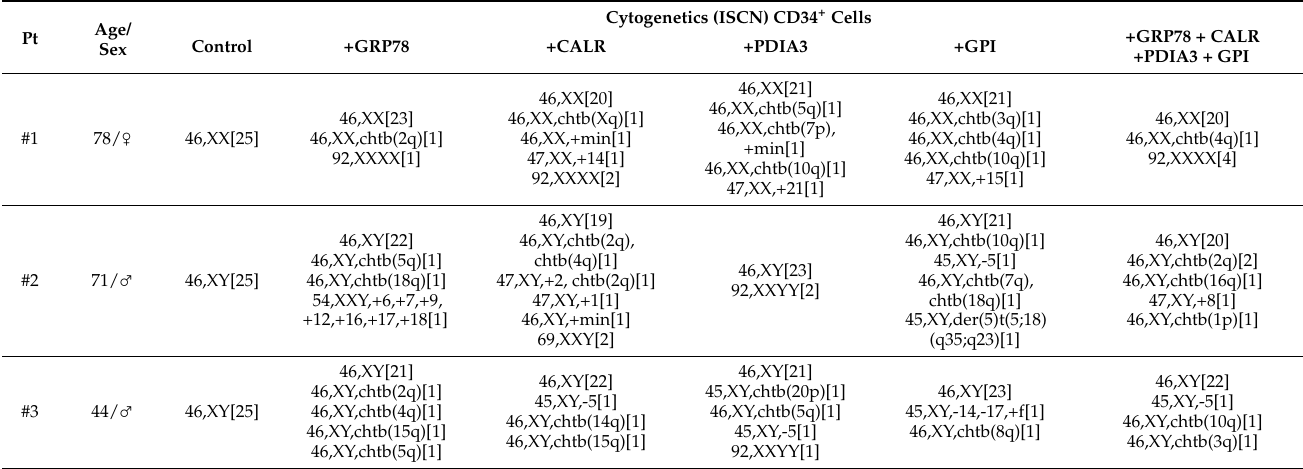
Table 1. Cytogenetics in CD34+ cells grown for 3 days in medium supplemented with recombinant GRP78, CALR, PDIA3 and GPI. chsb, chromosome break; chtb, chromatid break; ISCN, international system for human cytogenetic nomenclature; min, minute (acentric fragment smaller than the width of a single chromatid); f, fragment; Pt, patient; [number], number of analyzed